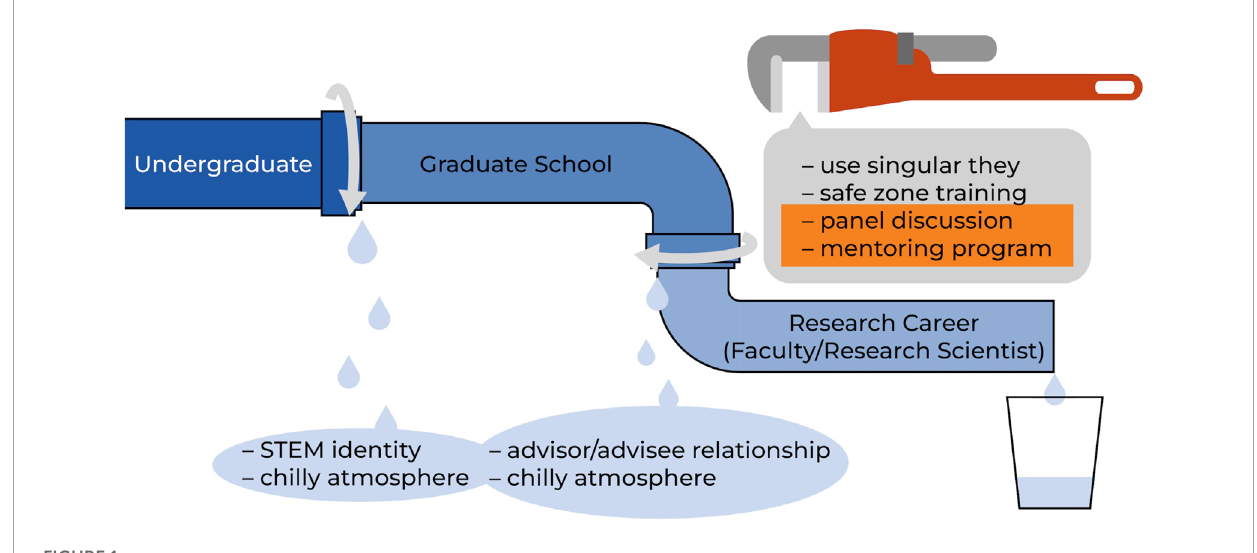
FIGURE 1 Conceptual diagram of obstacles HUG students face while pursuing a research career. The highlighted text under the pipe wrench indicates the scope of HUG